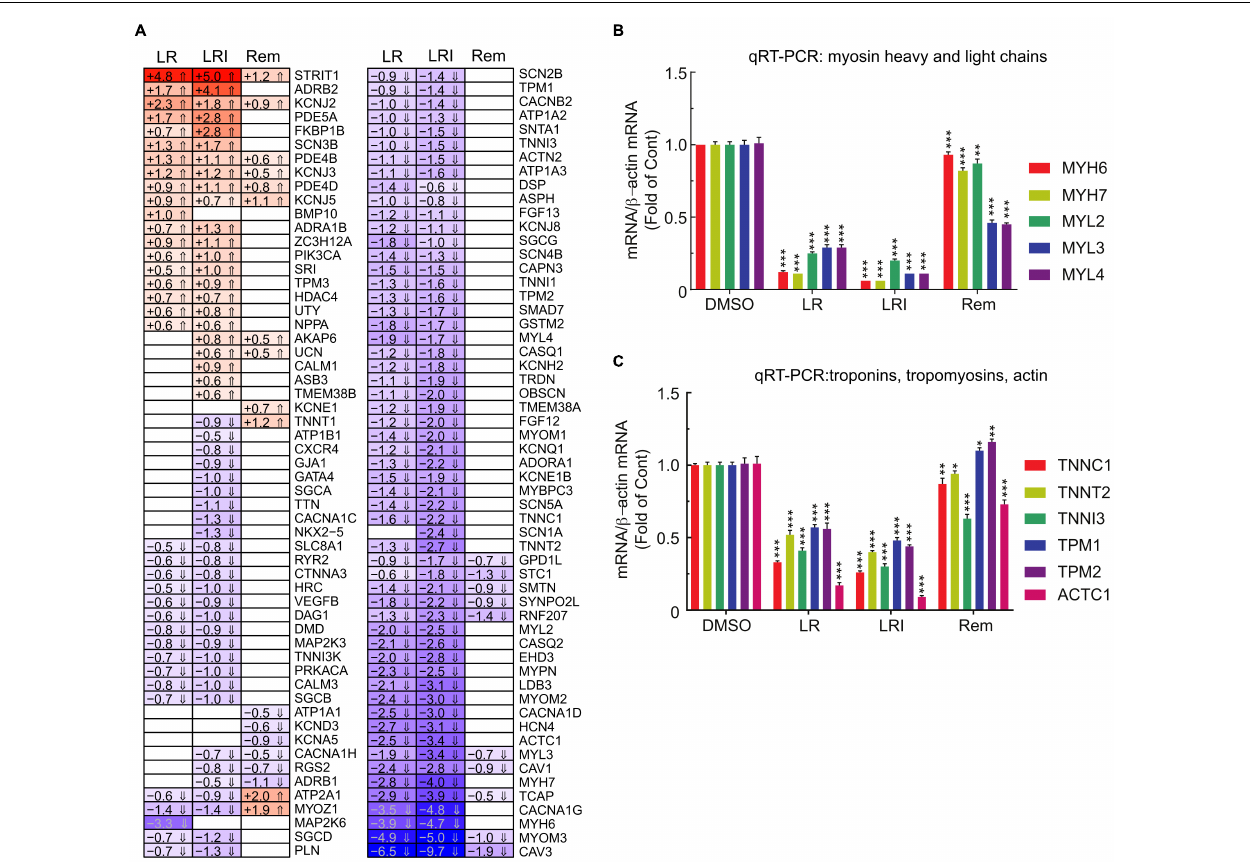
FIGURE 5 | Calcium handling-associated genes and genes associated with sarcomere organization with LR, LRI, and Rem treatment. (A) Clustered heatmap of a panel of 100 selected genes associated with calcium handling and sarcomere organization showing the calculated Log2 fold change after LR, LRI, and Rem treatment compared to control (FDR ≤ 0.05, |Log2 fold change| ≥ 0.5). LR: lopinavir/ritonavir; LRI: lopinavir/ritonavir + interferon- β ; Rem: remdesivir. (B) Expression of myosin light and heavy chains was determined by qRT-PCR using total RNA from hiPSC-CMs plated at 1 × 10 6 cells/well on 6-well culture dishes and treated for 24 h with LR, LRI, or Rem. (C) Expression of selected troponin, tropomyosin, and actin genes was determined by qRT-PCR using total RNA from hiPSC-CMs plated at 1 × 10 6 cells/well on 6-well culture dishes and treated for 24 h with LR, LRI, or Rem. Two-group comparisons were performed using Student’s two-tailed t -test. Data are represented as mean with all error bars indicating ± s.e.m. * P ≤ 0.05, ** P ≤ 0.01, and *** P ≤ 0.001 compared to DMSO